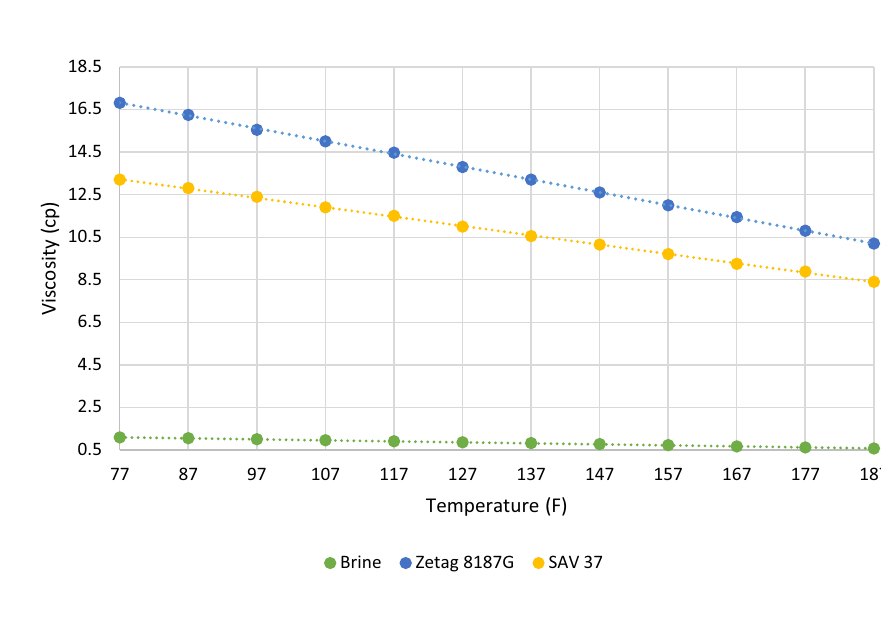
Fig. 6 Effect of the temperature on viscosity of solutions in 150,000 ppm